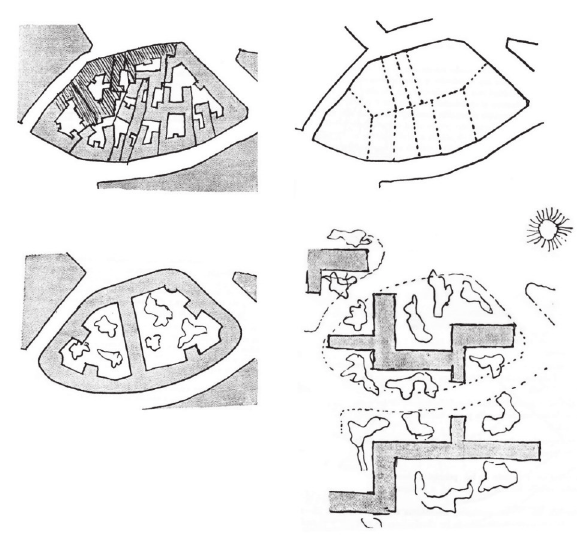
fig. 6. a process of urban renewal in four stages (le Corbusier 1946a: